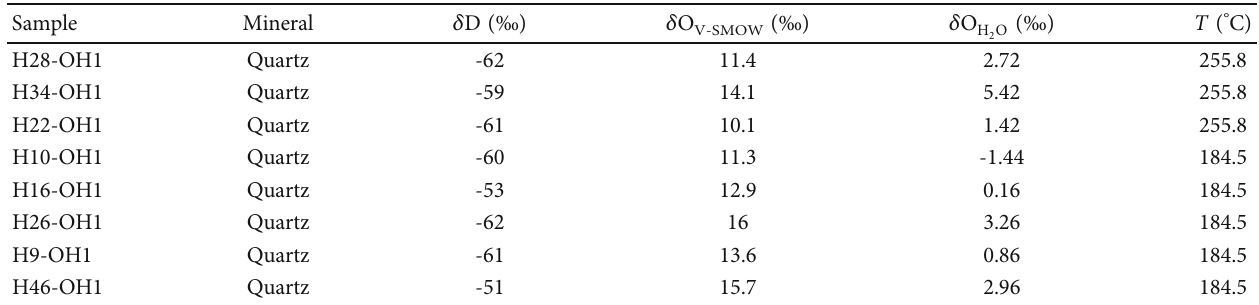
Table 6: Isotopic values of D and O of the Daping gold deposit. The values of the δ O ≈ 3 : 38 × 10 6 / T 2 − 3 : 40 [22].